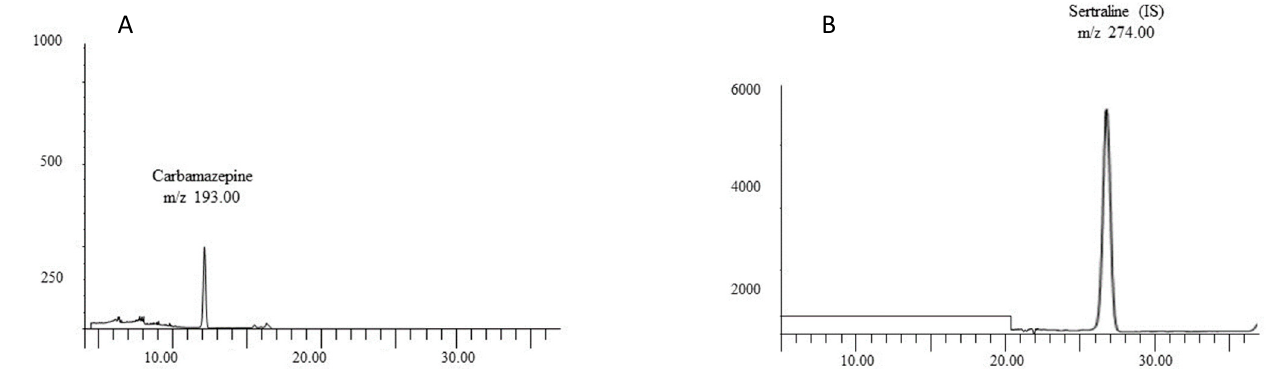
Figure 2. ( A ) SIM chromatogram of bone extracts from the real case containing approximately 46 ng/mg bone of carbamazepine. ( B ) SIM chromatogram for sertraline (IS) of bone extracts from the real case.